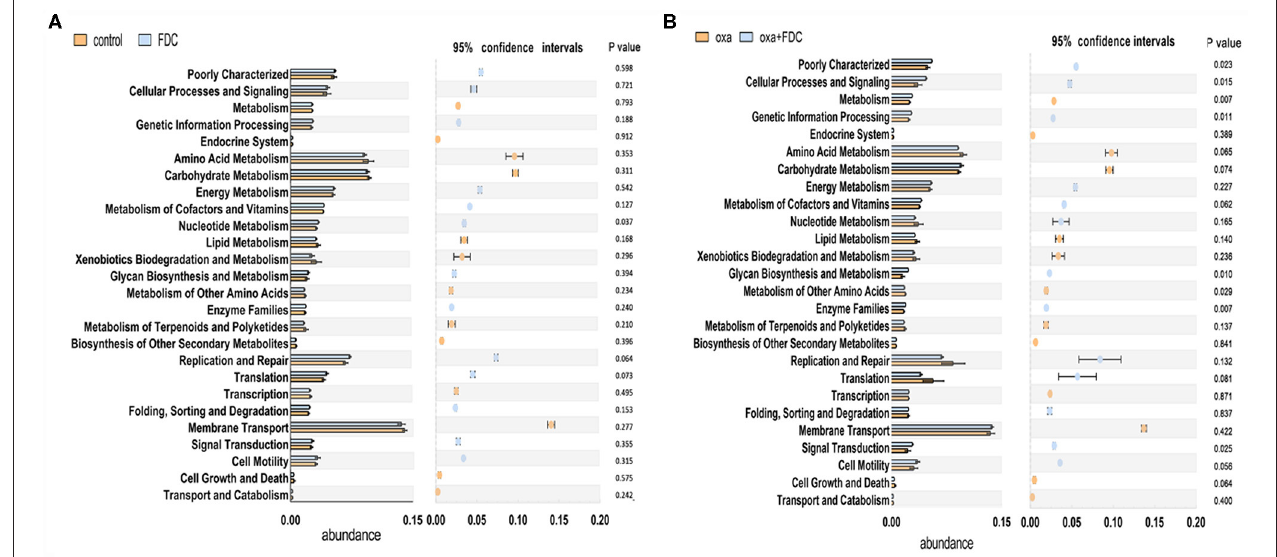
FIGURE 5 | Analysis of the relative abundance of metabolic pathways encoded in each input sample metagenome on day 21. (A) The control group and the FDC group were compared with the KEGG second-level functional group, (B) The oxa group and the oxa+FDC group were compared with the KEGG second-level functional